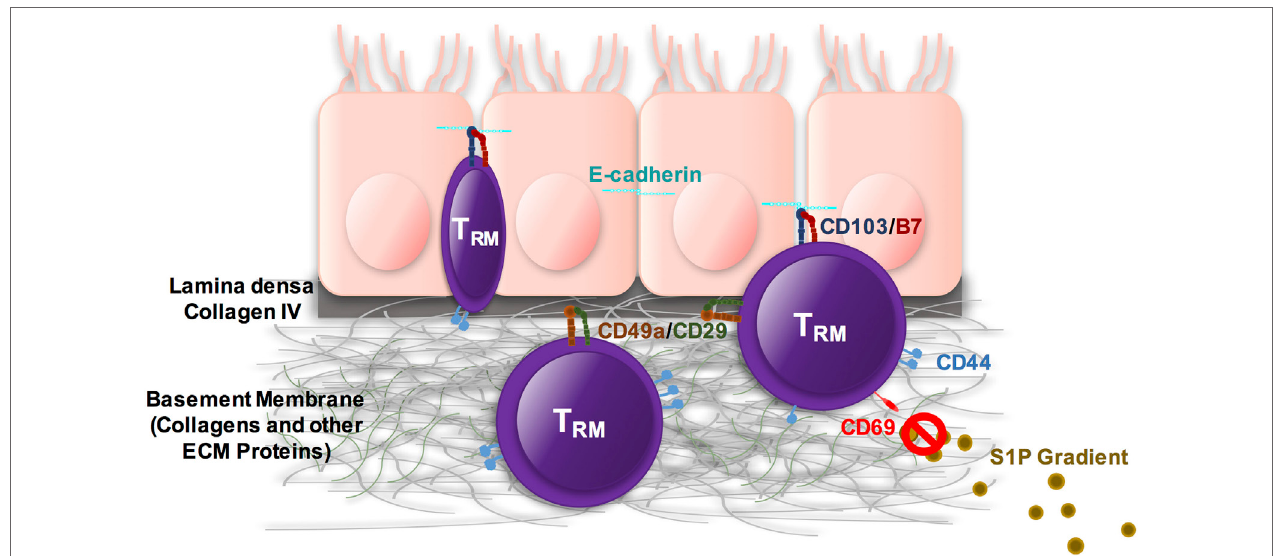
FiGURe 1 | TRM cells are heterogenous both within tissues and also between sites. They express some combination of CD49a, CD103, CD44, and CD69, which cooperate to position the cells and maintain them within the site of initial infection. CD103 can interact with E-cadherin within epithelial surfaces. CD49a interacts with collagens with a preference for collagen IV in the lamina densa underlying the epithelium. CD44 maintains cell shape and integrity and can interact with a number of different tissue components including hyaluronic acid as well as fibronectin and other ECM proteins. CD69 antagonizes S1P 1 , essentially blocking any response to S1P